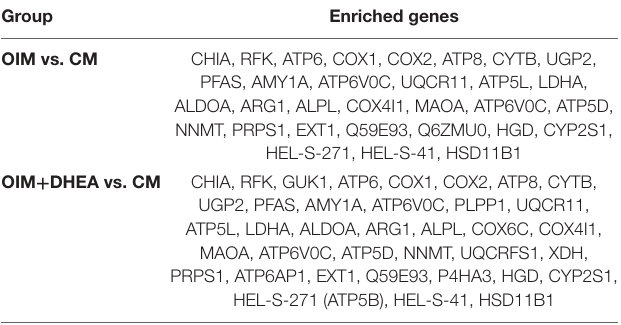
TABLE 3 | Proteins enriched in metabolic